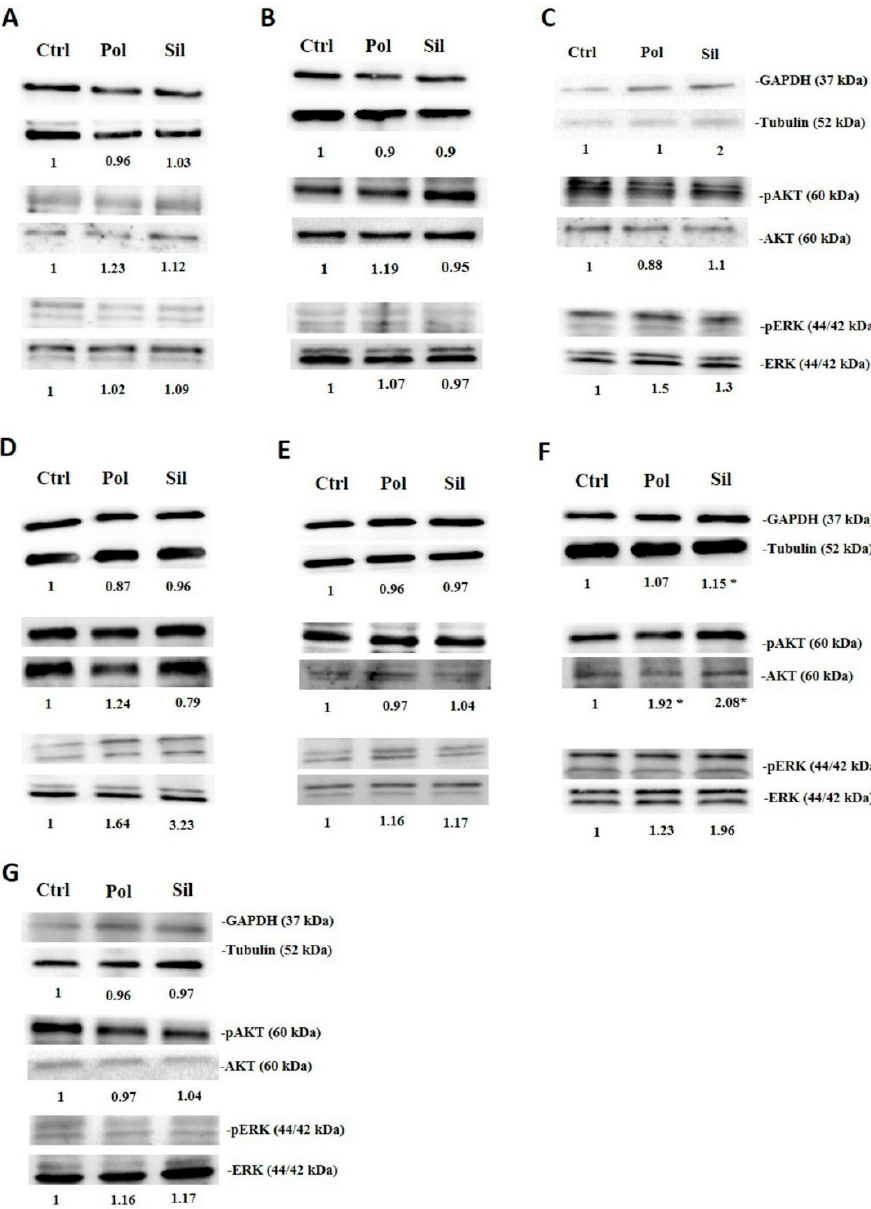
Figure 10. Nanoparticles effects on tumor intracellular signalling. Tumor cells were incubated with polymeric (pol) or silica (sil) nanoparticles (20 µ g / mL) for 24 h. Then, cell lysates were immunoblotted with anti-pERK1 / 2 and anti-ERK1 / 2, anti-pAKT ser 473 and anti-AKT, anti-GAPDH and anti-tubulin. ( A ). MV3 ( B ). MDA-MB-231 ( C ). MCF-7 ( D ). U373 ( E ). PC-3 ( F ). AGS ( G ). HT-29. Results are presented as the mean ± SD calculated from three independent experiments (* p < 0.05).